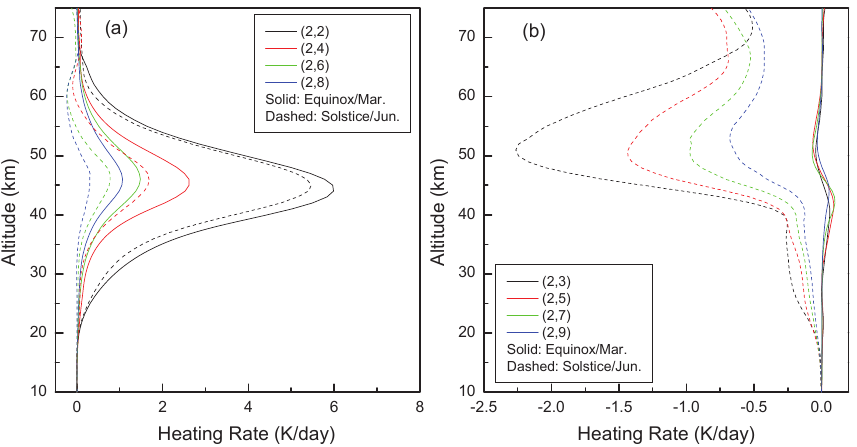
Fig. 10. The multi-year averaged vertical profiles of the symmetric (a) and asymmetric (b) semidiurnal Hough functions for equinox/March (solid line) and solstice/June (dashed line).